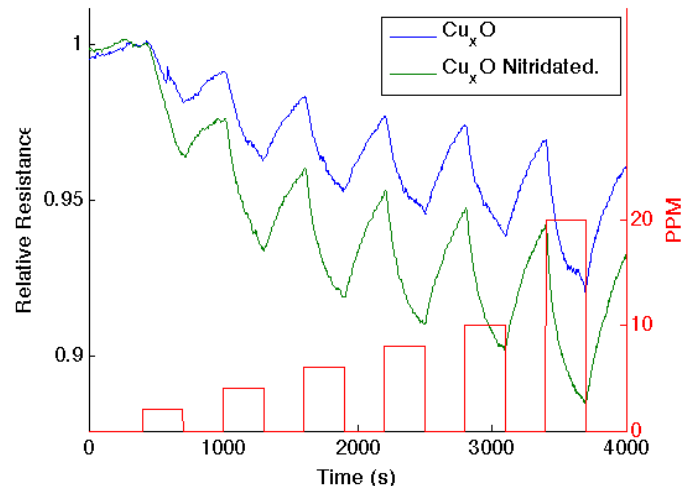
Figure 4. Response corresponding to decreasing resistance as NH O-treated porous silicon ( blue line ) and nitridated Cu to a Cu x ( green line ). The nitridated Cu Cu O-treated PS acidic sites. x